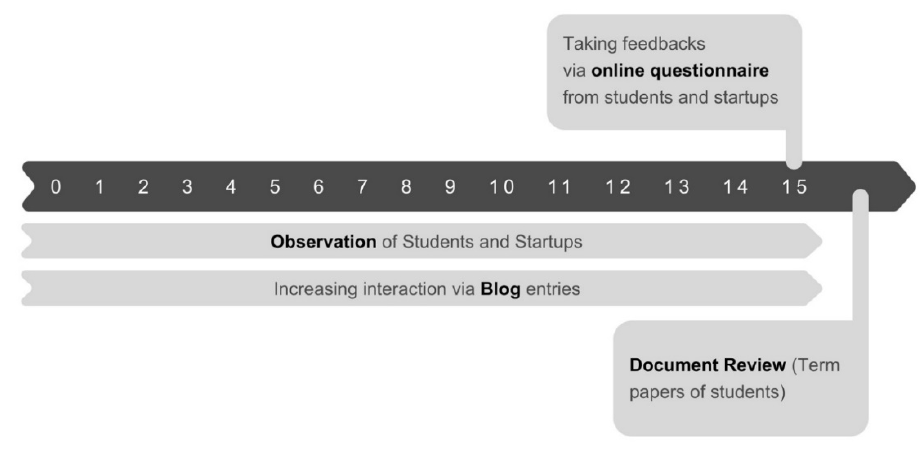
Figure 2: Chronological summary of data collecting